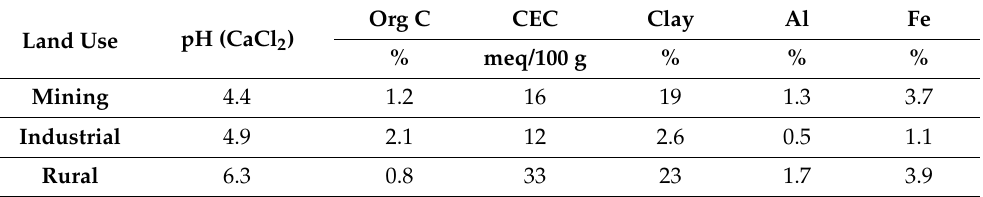
Table 1. Soil properties, Al and Fe content for agricultural soils (mining, industrial and rural). Org C CEC Clay Al Fe Land Use pH (CaCl 2 ) % meq/100 g